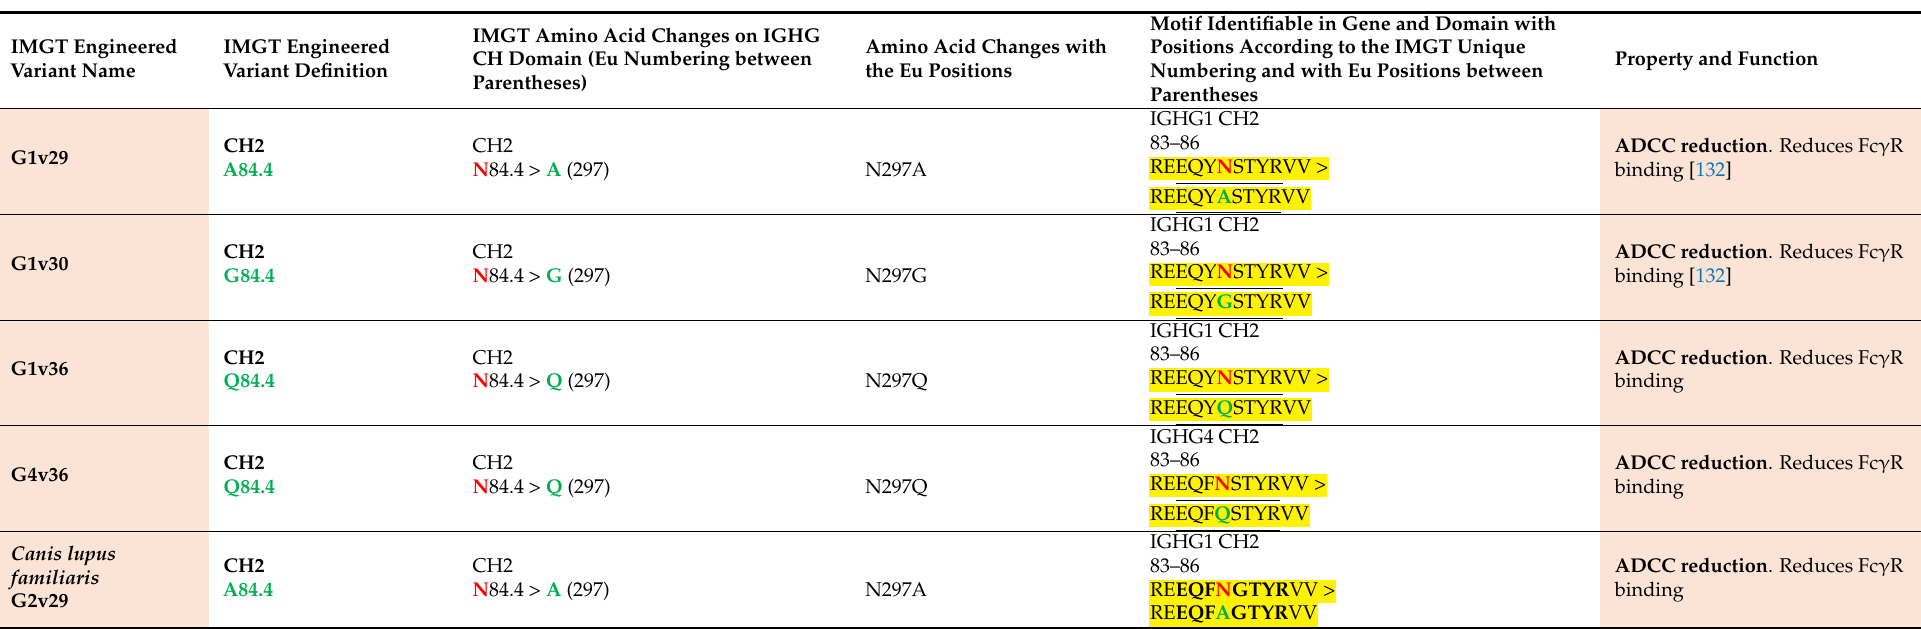
Table 12. IMGT nomenclature, Eu positions and IMGT motif of engineered Fc variants involved in the knock out CH2 84.4 glycosylation (Effector